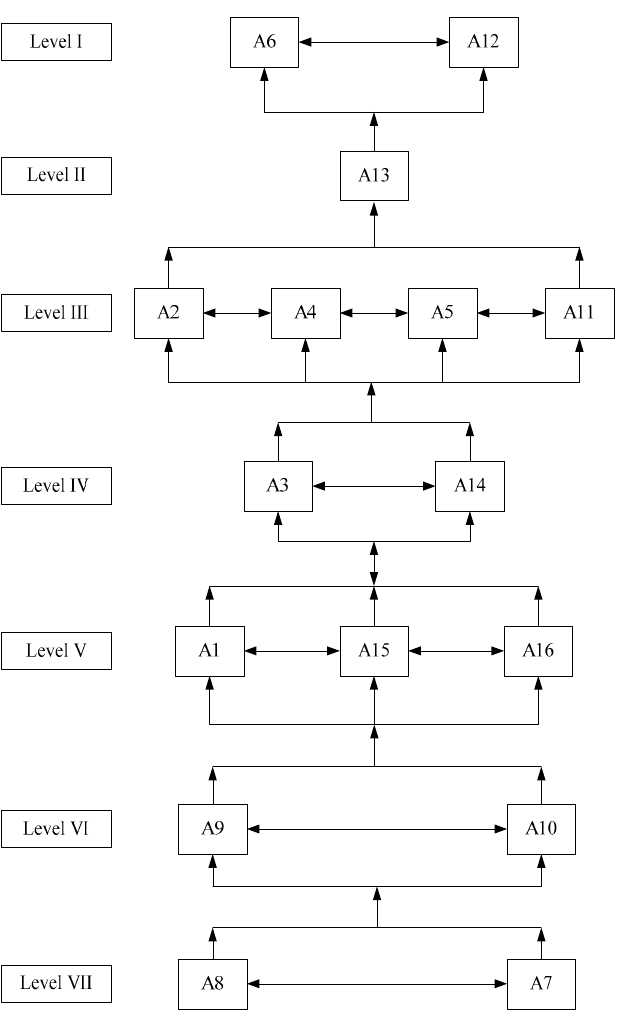
Figure 2. Interpretive structural modeling-based influence diagram for the blockchain adoption criteria in university.